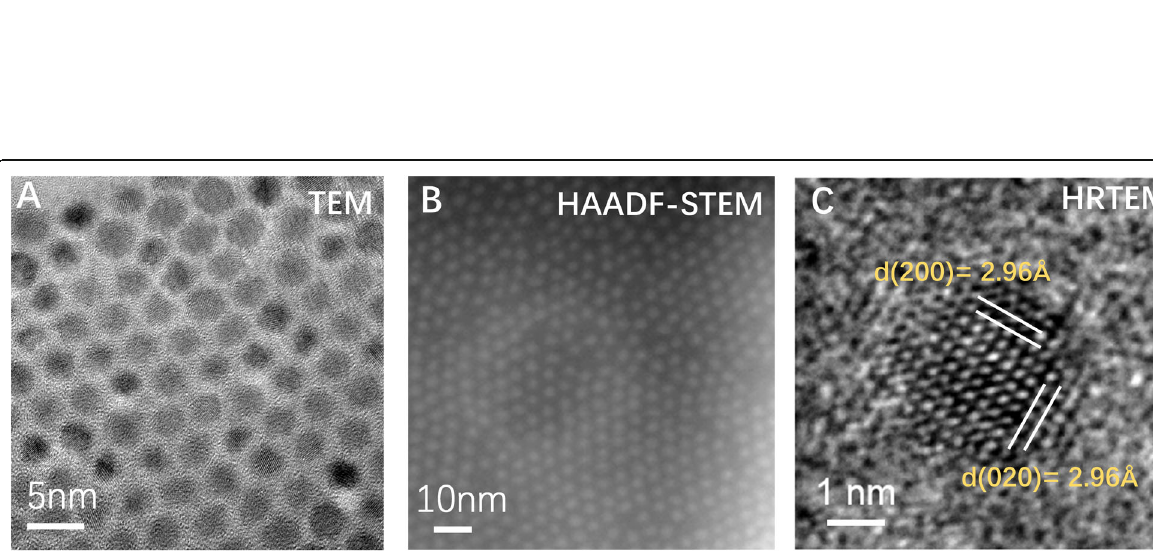
Fig. 3 TEM images of PbS nanocrystals sample via new preparation method. a TEM image at low magnification. b image of nanocrystals under HAADF-STEM mode. c image of